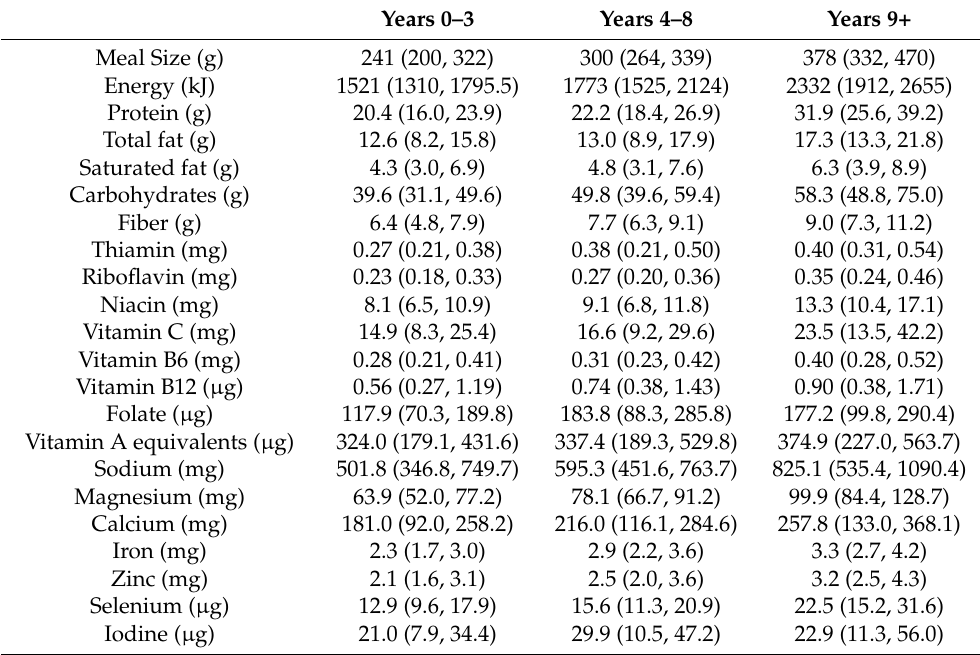
Table 3. Nutrient levels in Ka Ora, Ka Ako meals in each year group